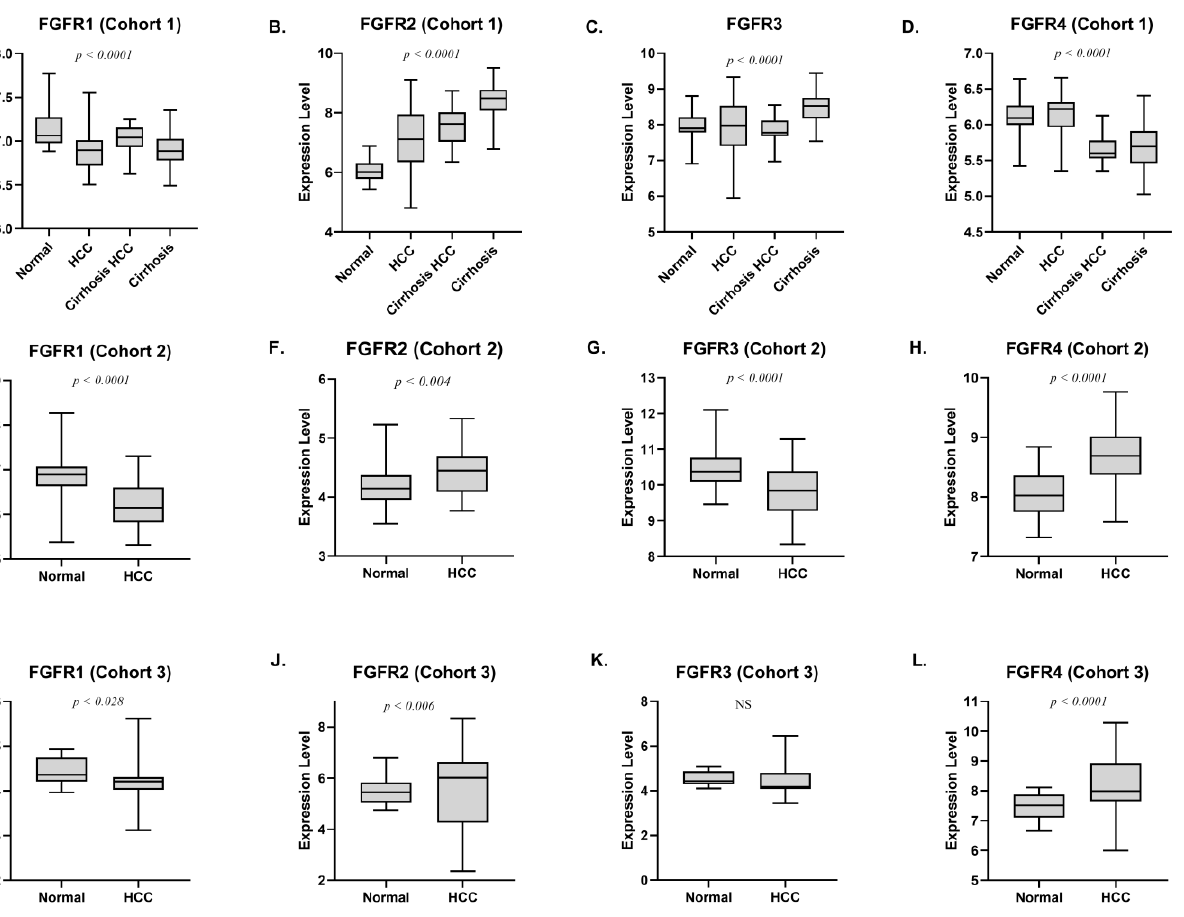
Figure 3. ( A ) Expression analysis of FGFR1 in different states of disease in cohort 1. ( B ) Expression analysis of FGFR2 in different states of disease in cohort 1. ( C ) Expression analysis of FGFR3 in different states of disease in cohort 1. ( D ) Expression analysis of FGFR4 in different states of disease in cohort 1. ( E ) Expression analysis of FGFR1 in HCC in cohort 2. ( F ) Expression analysis of FGFR2 in HCC in cohort 2. ( G ) Expression analysis of FGFR3 in HCC in cohort 2. ( H ) Expression analysis of FGFR4 in HCC in cohort 2. ( I ) Expression analysis of FGFR1 in HCC in cohort 3. ( J ) Expression analysis of FGFR2 in HCC in cohort 3. ( K ) Expression analysis of FGFR3 in HCC in cohort 3. ( L ) Expression analysis of FGFR2 in HCC in cohort 3.